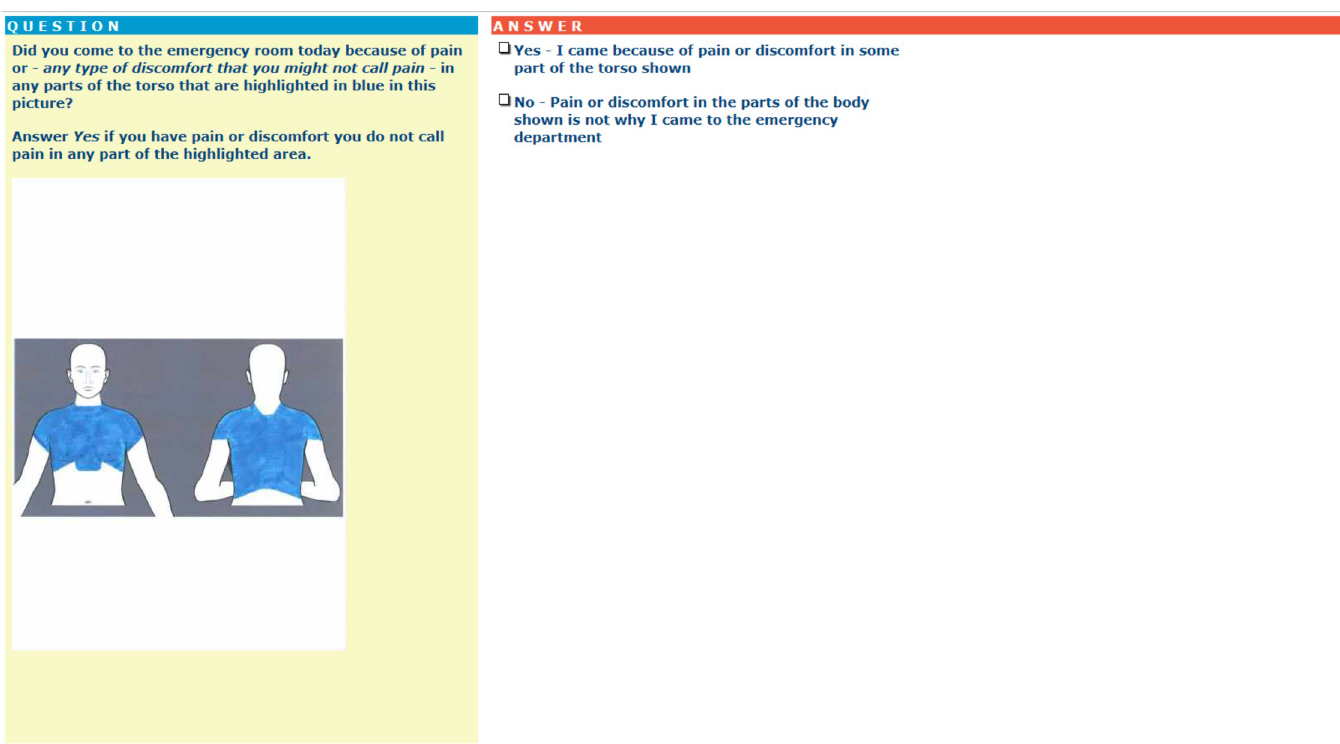
Fig 1. Image presented to patients to confirm that chest pain was the chief complaint. Patients were asked to confirm with a "yes" or "no" that they were seeking medical care because of pain somewhere in the blue region of the